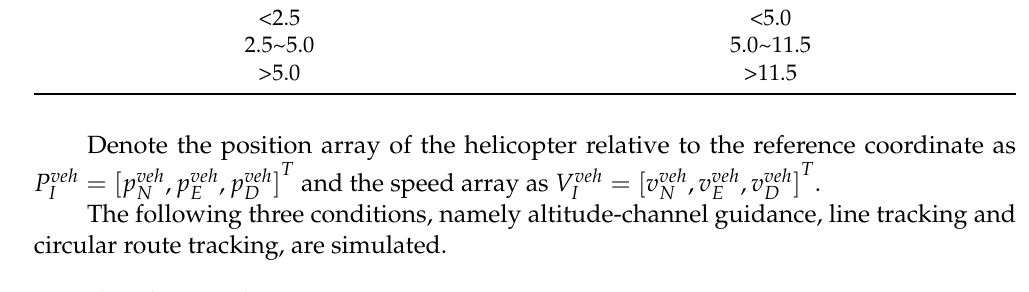
Figure 16. The evolution of corresponding height vs. time. Since ATD generates the reference trajectory according to the second-order system optimal control process, which includes definite acceleration and deceleration stages, the reference trajectory contains speed and acceleration information, and the transition pro- cess is more reasonable. As can be seen from the partially enlarged drawing, there is no visible overshoot at the end of the descent stage, which makes it easier to ensure flight safety in autonomous landing applications. Set the altitudinal velocity of the helicopter, i.e., the change rate of altitude, as veh H D v v = − . The evolution of reference velocity R H v